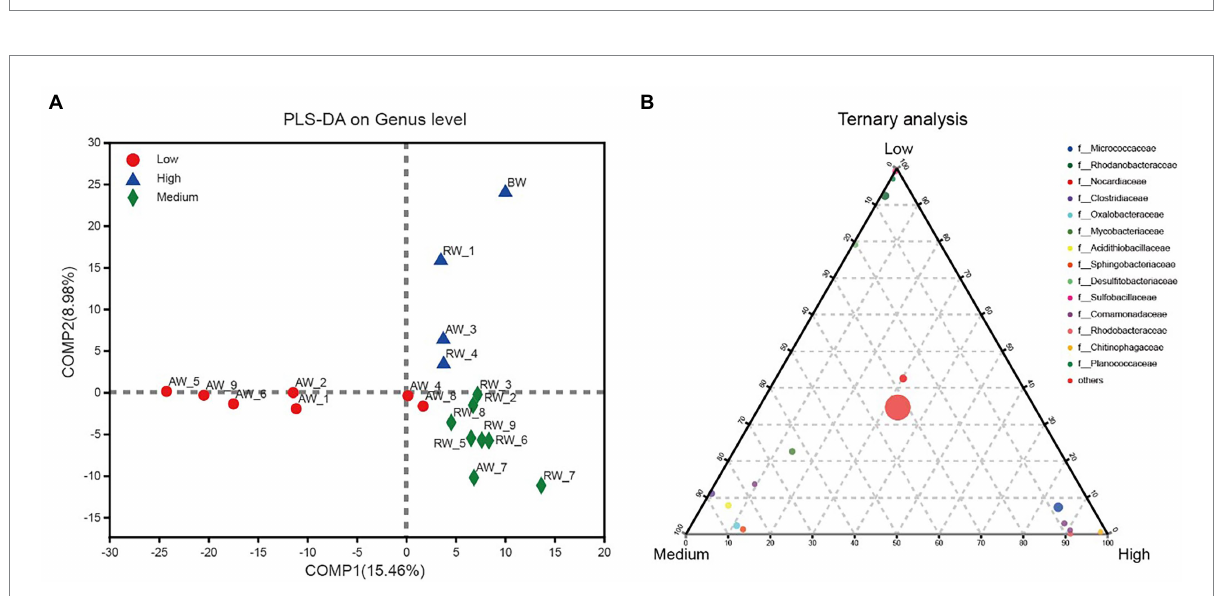
FIGURE 9 (A) PLS-DA analysis for three groups of groundwater samples which were divided into three groups according to the size of pH values, with pH < 3.0 (Low); 3.0 < pH < 5.0 (Medium); pH > 5.0 (High). (B) Ternary analysis for the groups of samples from (A) . In the ternary analysis, the abundances of the grouped samples were averaged, and others was the pooled set of taxa whose abundance accounted for less than